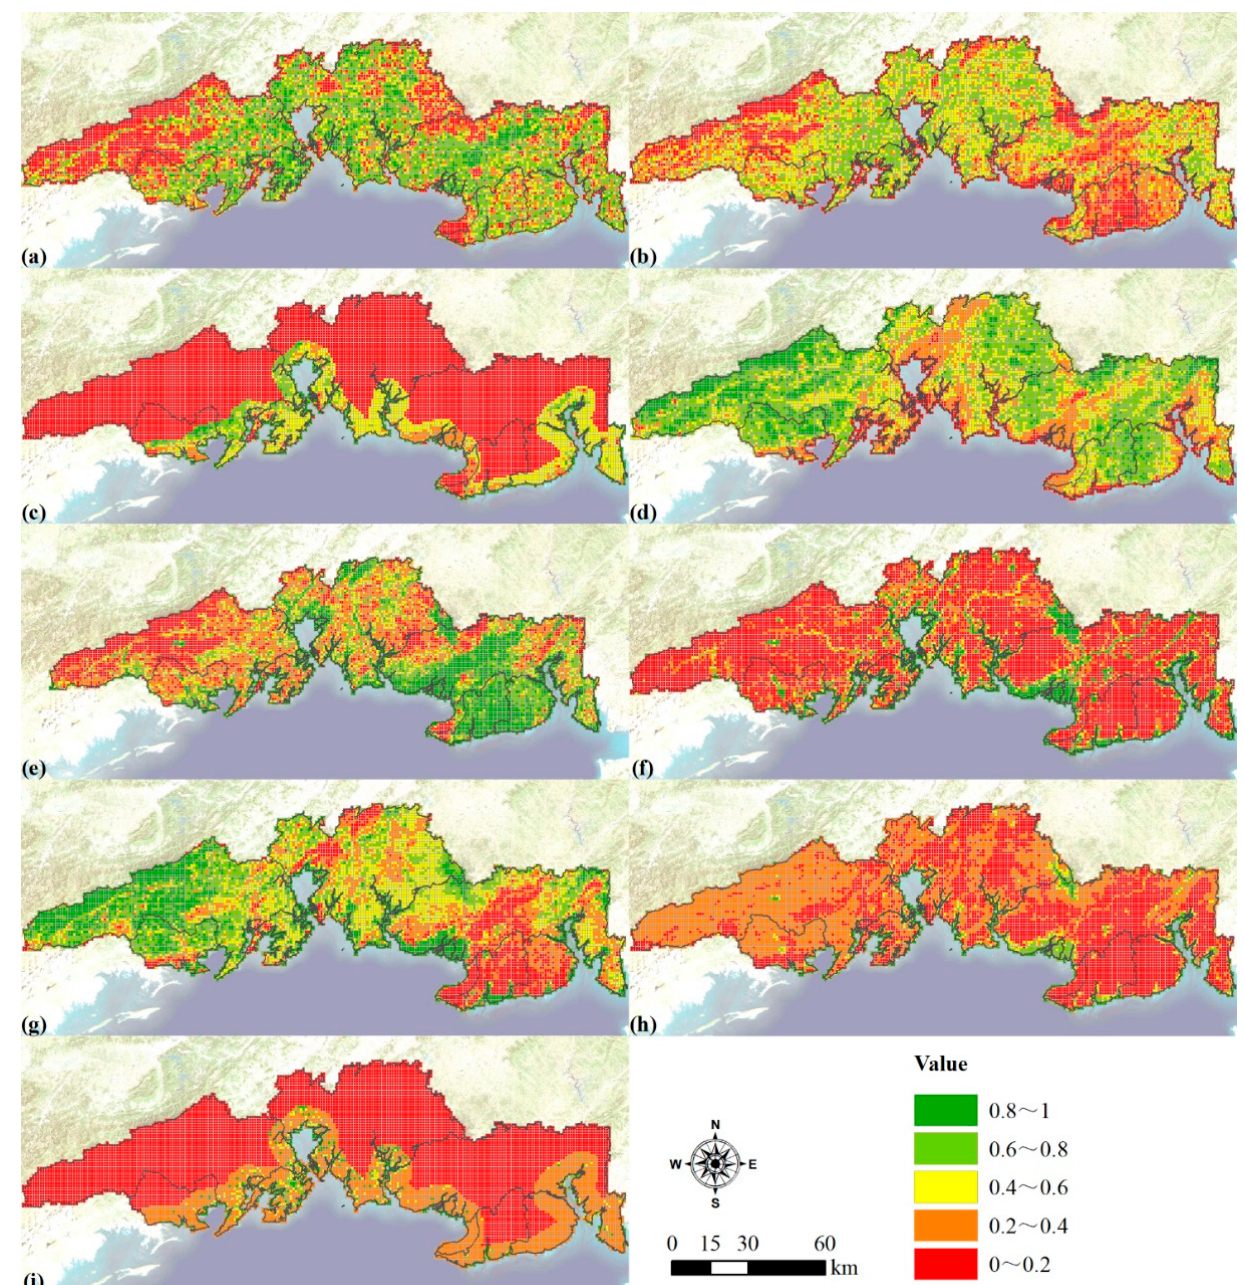
Figure 4. Assessing results for development potential of construction land ( a ), potential of cultivated land ( b ), development potential of coastal zone ( c ), water resources support capacity ( d ), water supply capacity ( e ), hydrological regulation ability ( f ), biodiversity ( g ), environmental purification capability ( h ) and ecological importance of coastal zone ( i ) in the study area with 1 km grid.